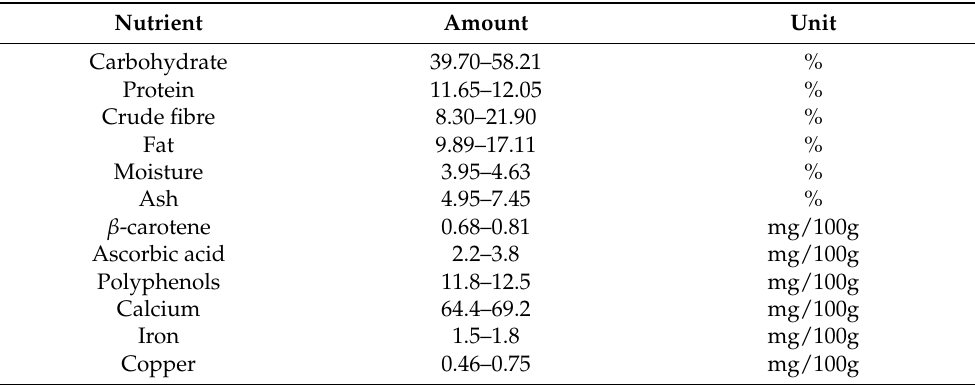
Table 1. Nutritional composition of dried ginger powder as reported by Ajayi et al. [19] and Sangwan et al.